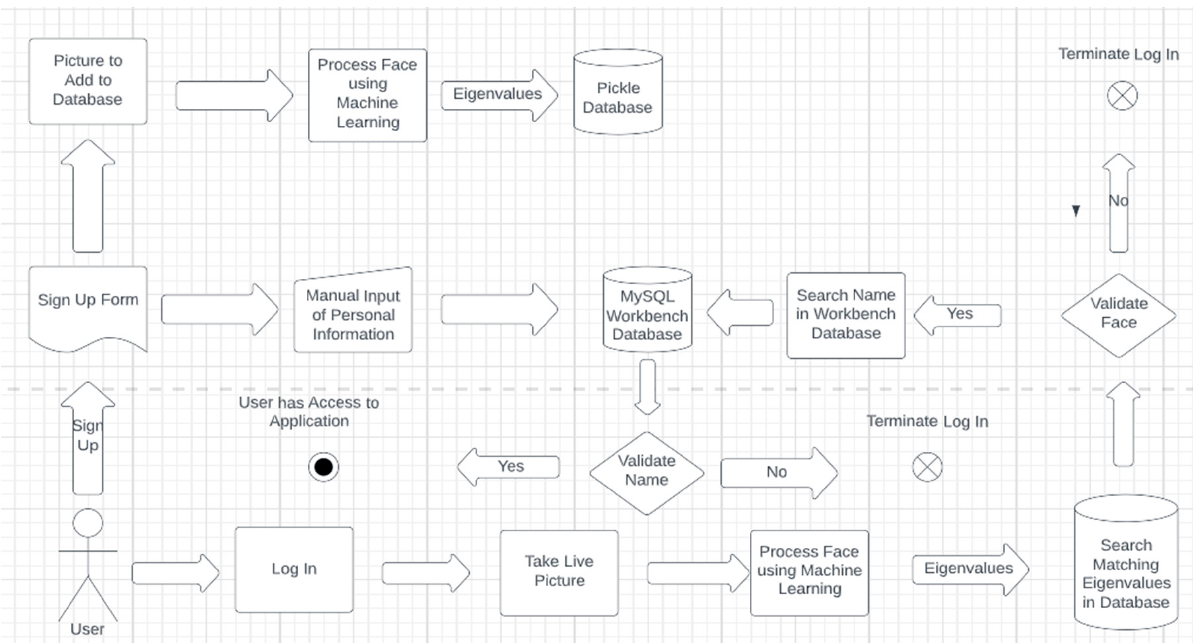
Figure 4. Architecture of the developed FR Software.